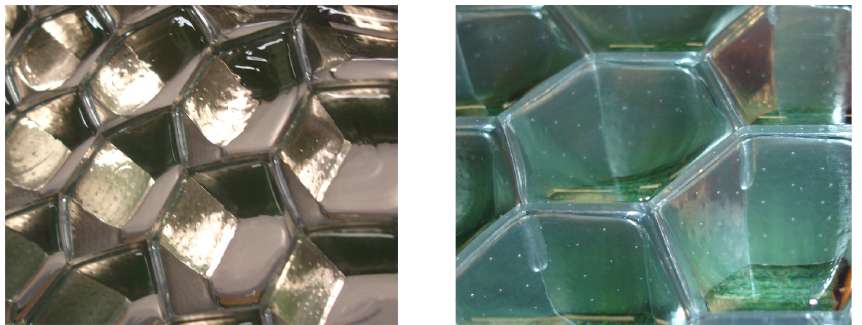
Figure 2a and b: Textures and tears in the adhesive layer related to wrong adhesives and wrong production